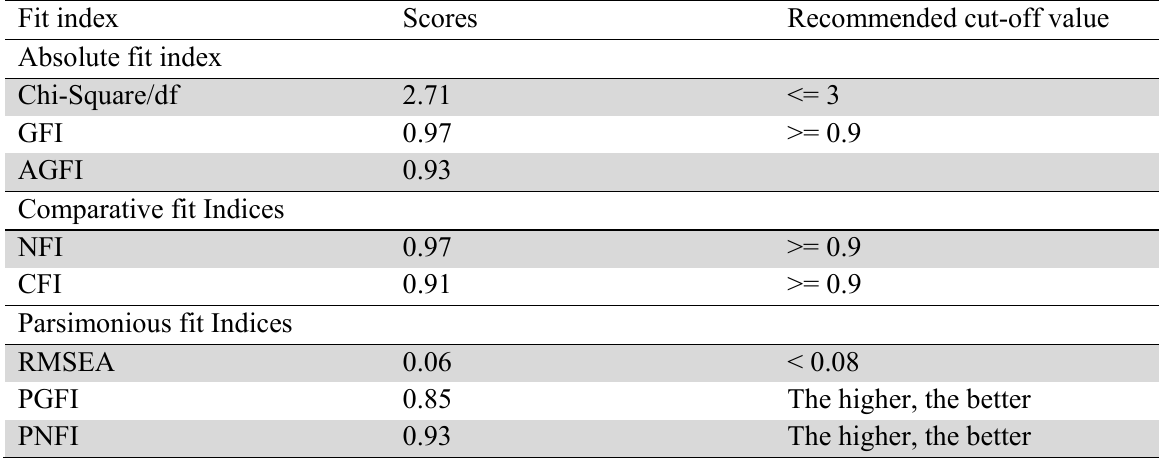
Overall fit indices of the CFA